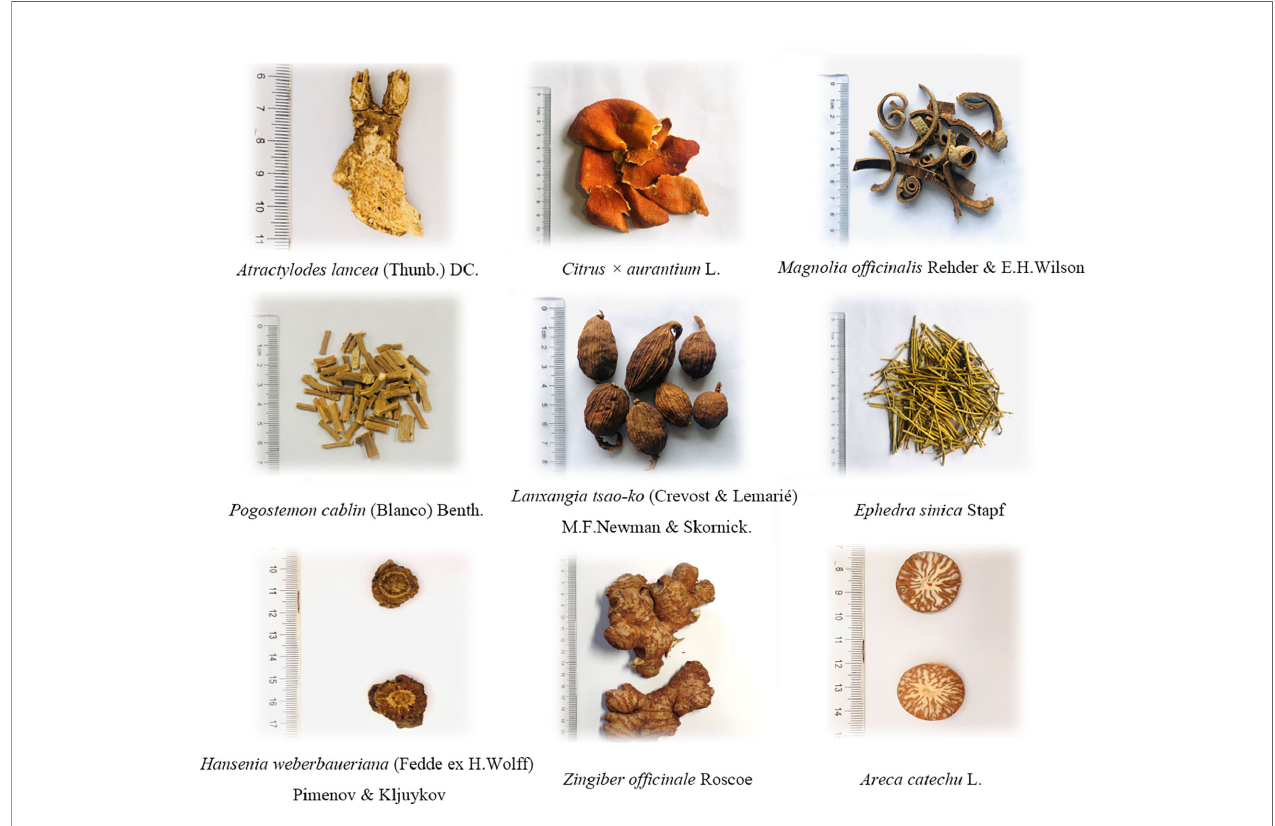
FIGURE 1 | The processed raw materials of Dayuan-Yin in treating